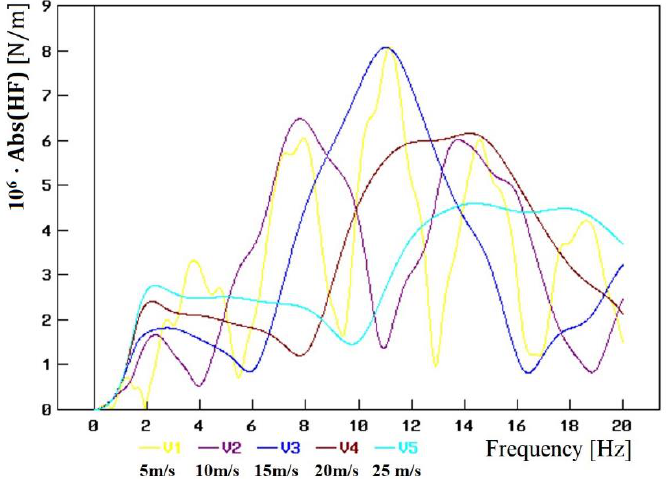
Figure 10. Modules of transmittance H F (i∙ω) of the force F on the joint between the tractor ’ s fifth wheel and semitrailer’s kingpin for the five-speed values v considered: 5 m/s, 10 m/s, 15 m/s, 20 m/s, and 25 m/s. 20 m/s, and 25